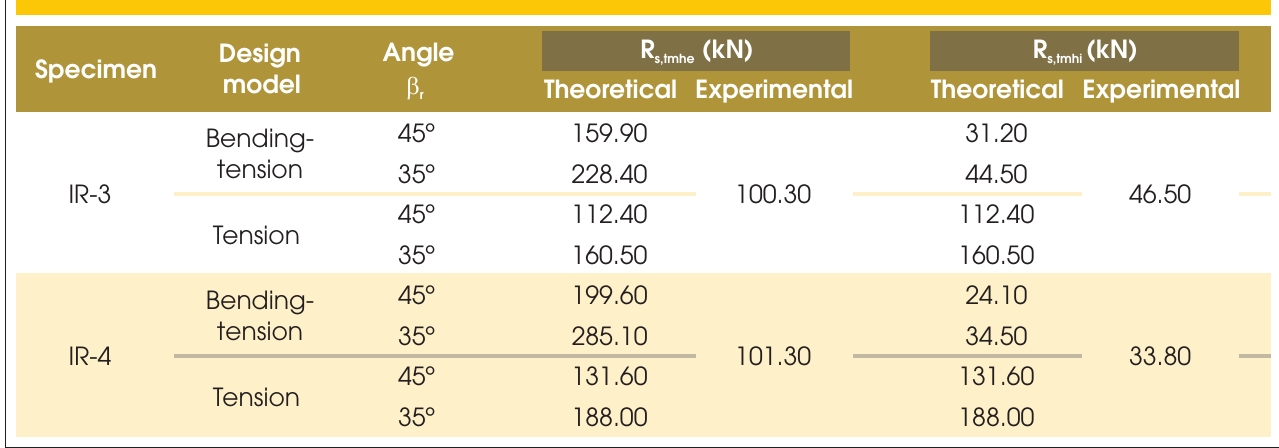
Table 3 – Theoretical and experimental internal forces in reinforcement A with varying angles o β for the rear transverse wall of rough interface sockets r